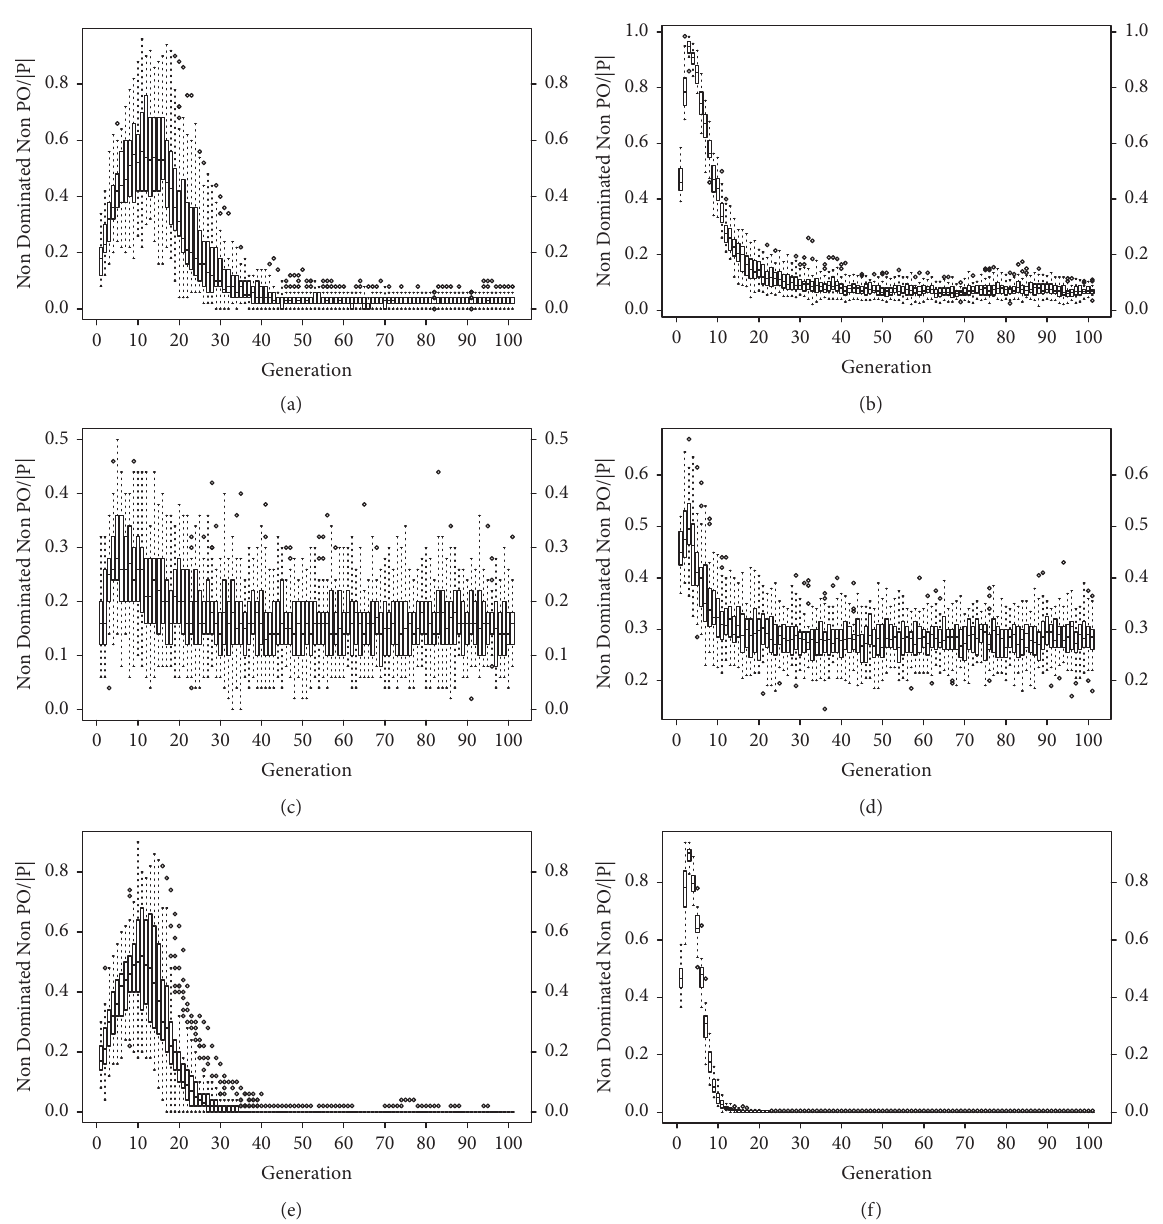
Figure 6: Nondominated solutions in the population that are not Pareto optimal. Population sizes 50 and 200 for 3 and 6 objectives. Algorithms A ϵ S ϵ H, MOEA/D, and IBEA . (a) A ϵ S ϵ H, | P | � 50, M � 3; (b) A ϵ S ϵ H, | P | � 200, M � 6; (c) MOEA/D, | P | � 50, M � 3; (d) HV MOEA/D, | P | � 200, M � 6; (e) IBEAHV, | P | � 50, M � 3; (f) IBEAHV, | P | � 200, M �